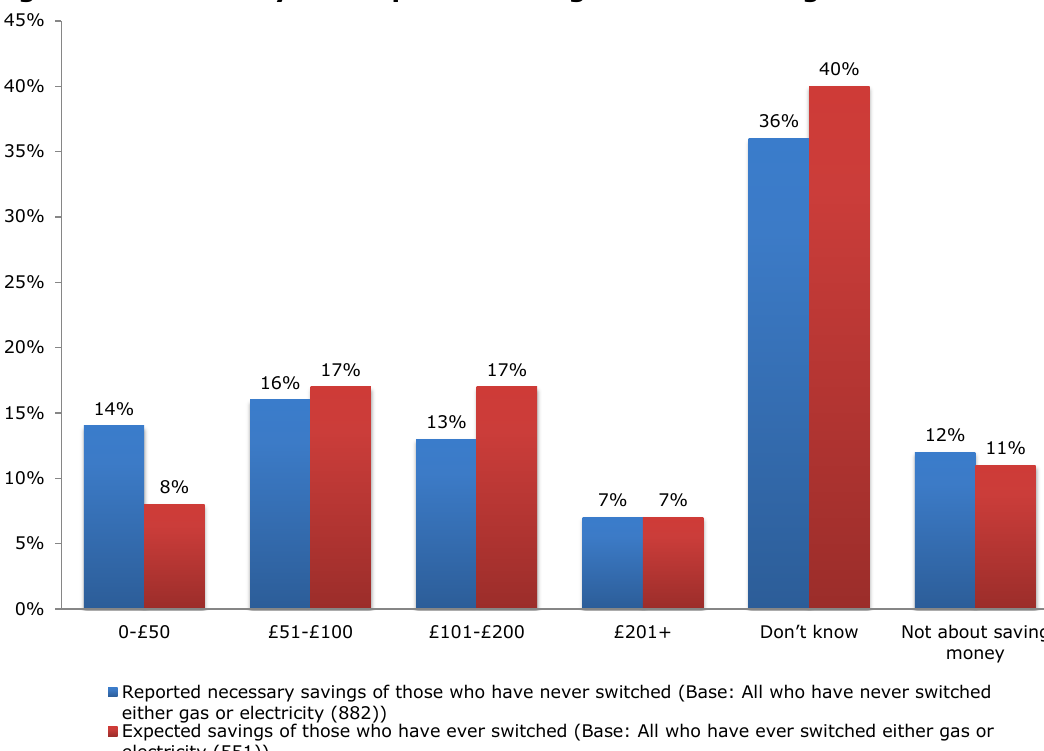
Figure 15: Necessary and expected savings from switching